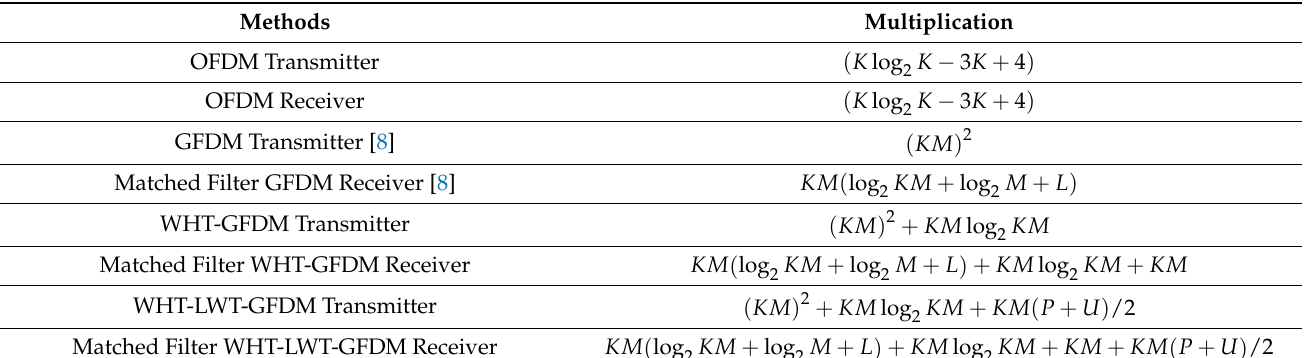
Table 1. Computational complexities of the waveform for AWGN